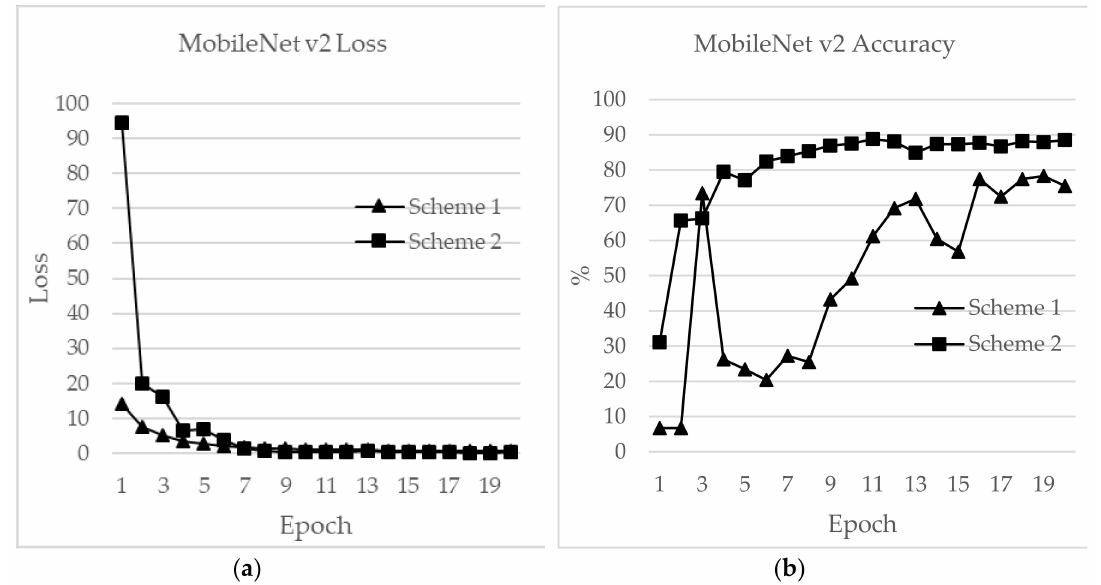
Figure 21. MobileNet v2 ( a ) loss curves and ( b ) accuracy curves.